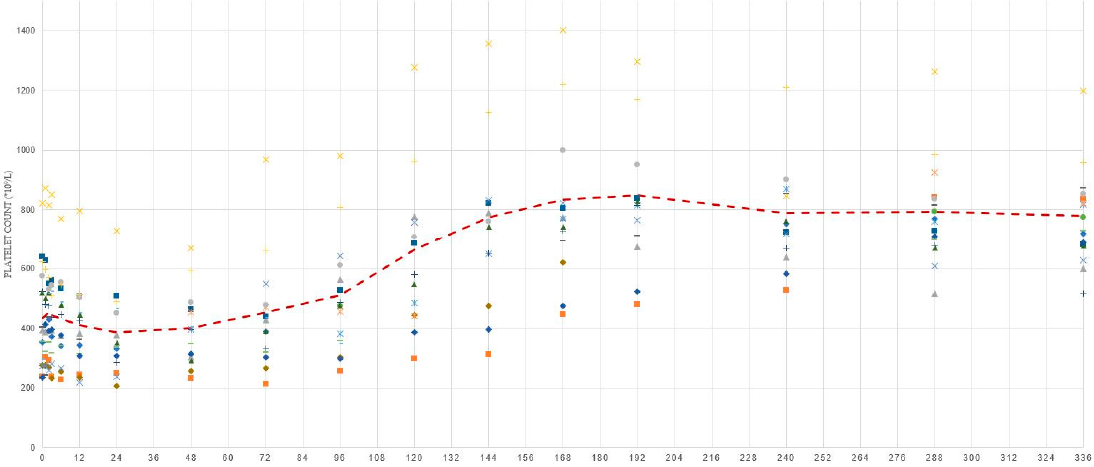
Figure 3. Scatter plot of platelet counts (×10 9 /litre) per calf over time in the longitudinal study and a dotted red line representing the mean platelet counts. Each symbol represents consecutive values from an individual calf.